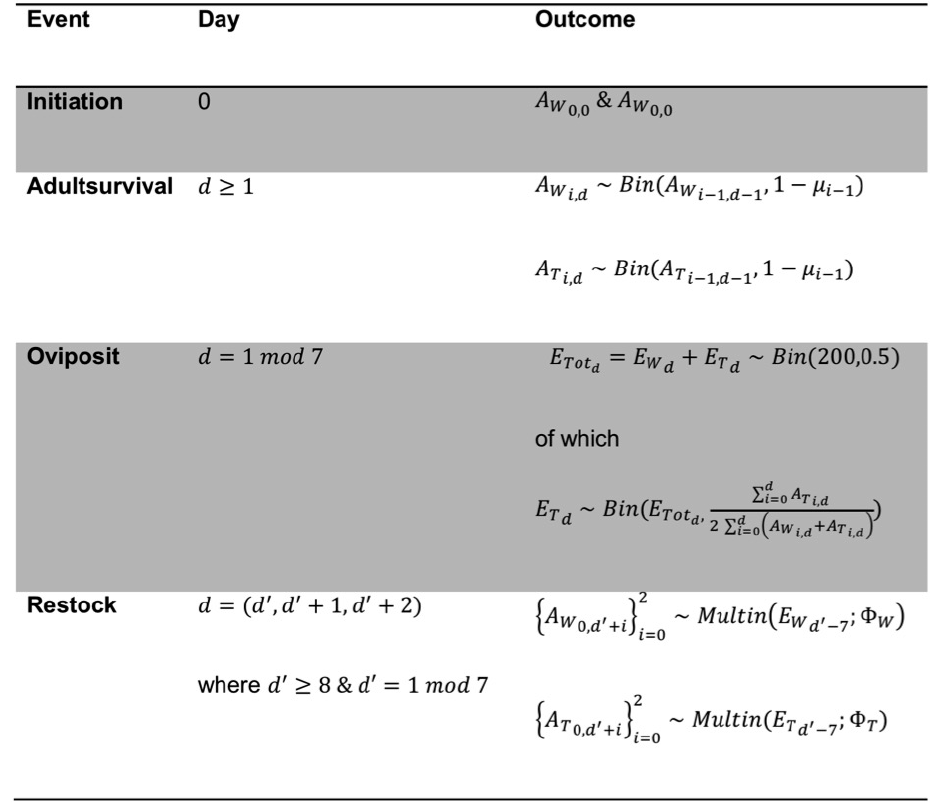
Figure 2. The simulation algorithm. The females in the population on day d are described by the variables ( A Wi , d , A Ti , d ) (adults, i denotes age) and ( E Wd , E Td ) (juveniles), where the subscript W or T denotes wildtype or transgenic. The parameter µ i is the probability an adult female dies at age i (derived from the survivorship function shown in Figure 1A), and Φ W and Φ T are the probability vectors of pupation after one, two, or three days (Figure 1B). The probability that a given egg is transgenic is half the fraction of transgenic individuals in the adult female population because all transgenic females are hemizygous (their fathers are non-transgenic), and Mendelian inheritance of the transgene has been confirmed experimentally [13,22].